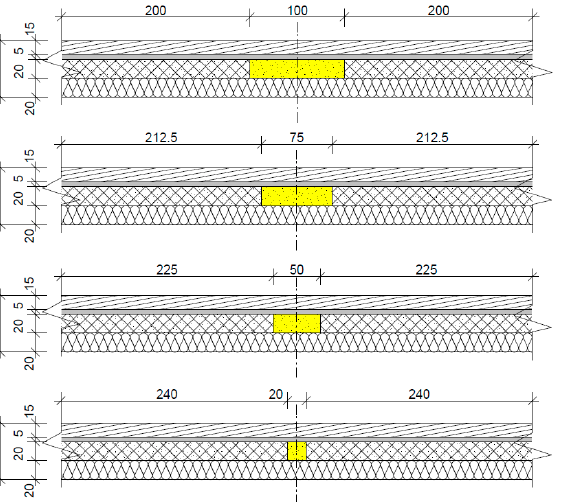
Figure 5. Diagram of a 60 mm thick panel with a PUR joint of 20–100 mm (yellow).